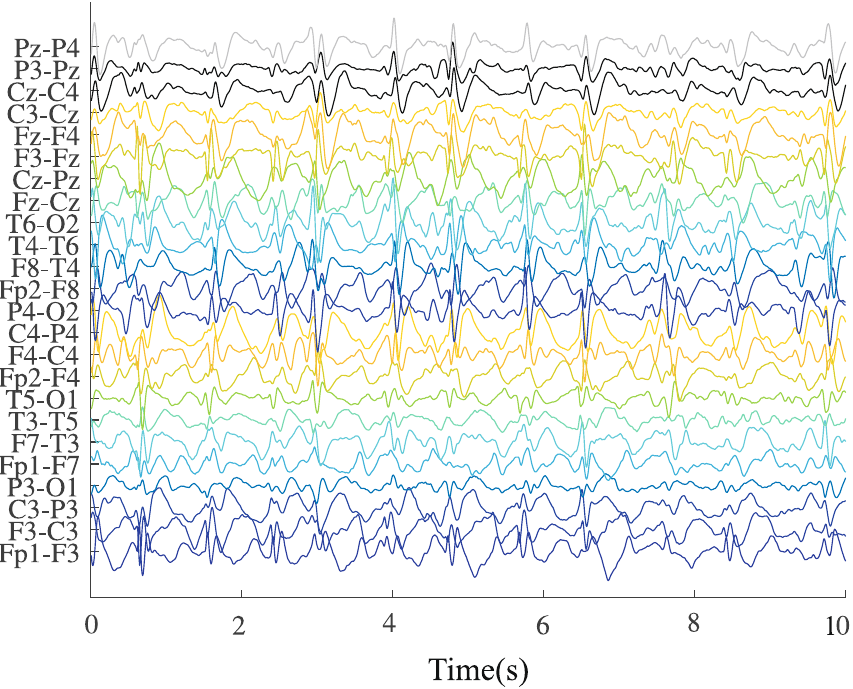
Figure 3. Hypsarrhythmic segments west syndrome—hips-WS.